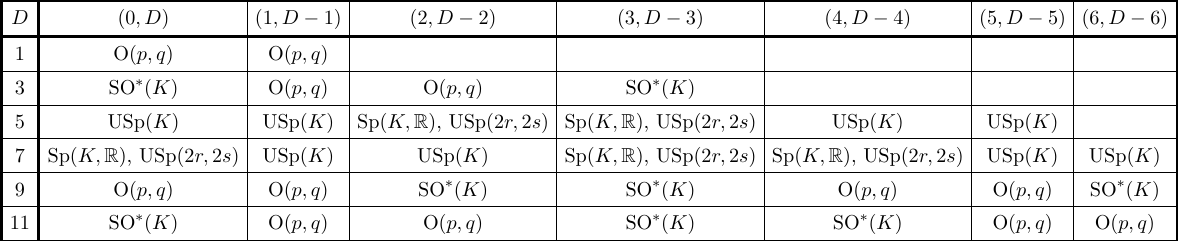
Table 4. This table lists the real R-symmetry groups which can occur in odd dimension with any signature, p + q = K